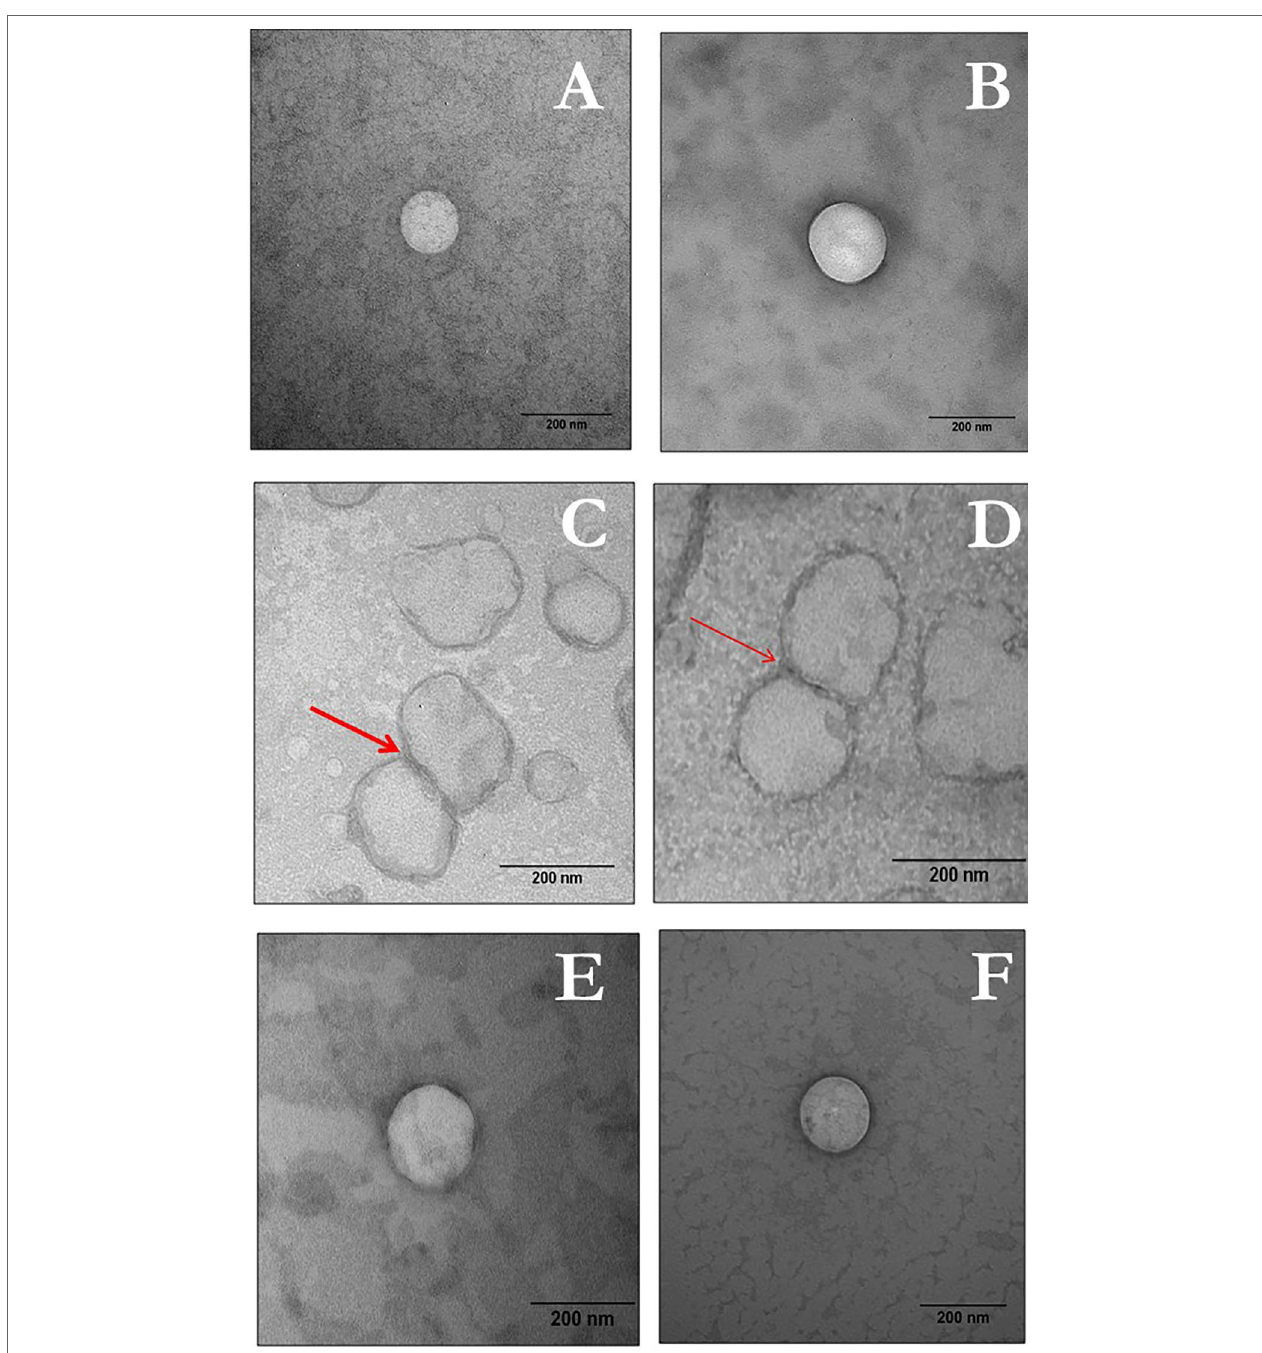
FIgUre 1 | TEM images of LUV VAN, LUV fuso VAN , and LUV ca VAN.The left panel represents plain vesicles and the right panel indicated VAN-containing LUVs as follows: (A , B) LUV; (C , D) LUV fuso ; and (e , F) LUV cat . Bars indicate 200 nm, with 100,000× magnification).